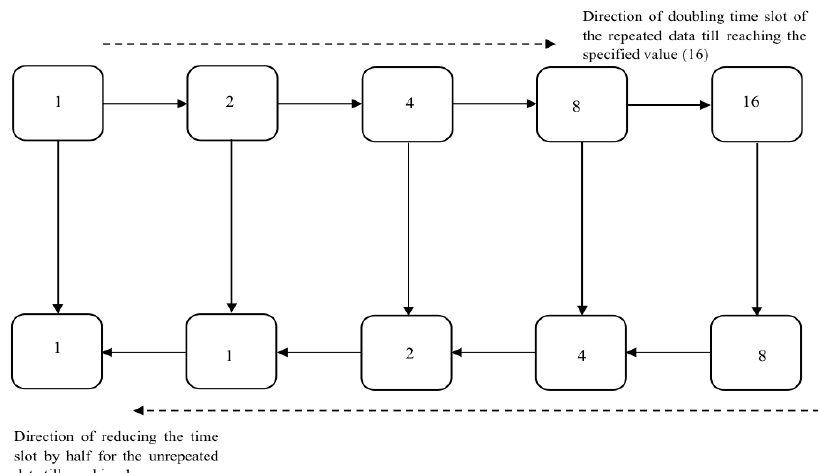
Fig. 4. DCRP flowchart